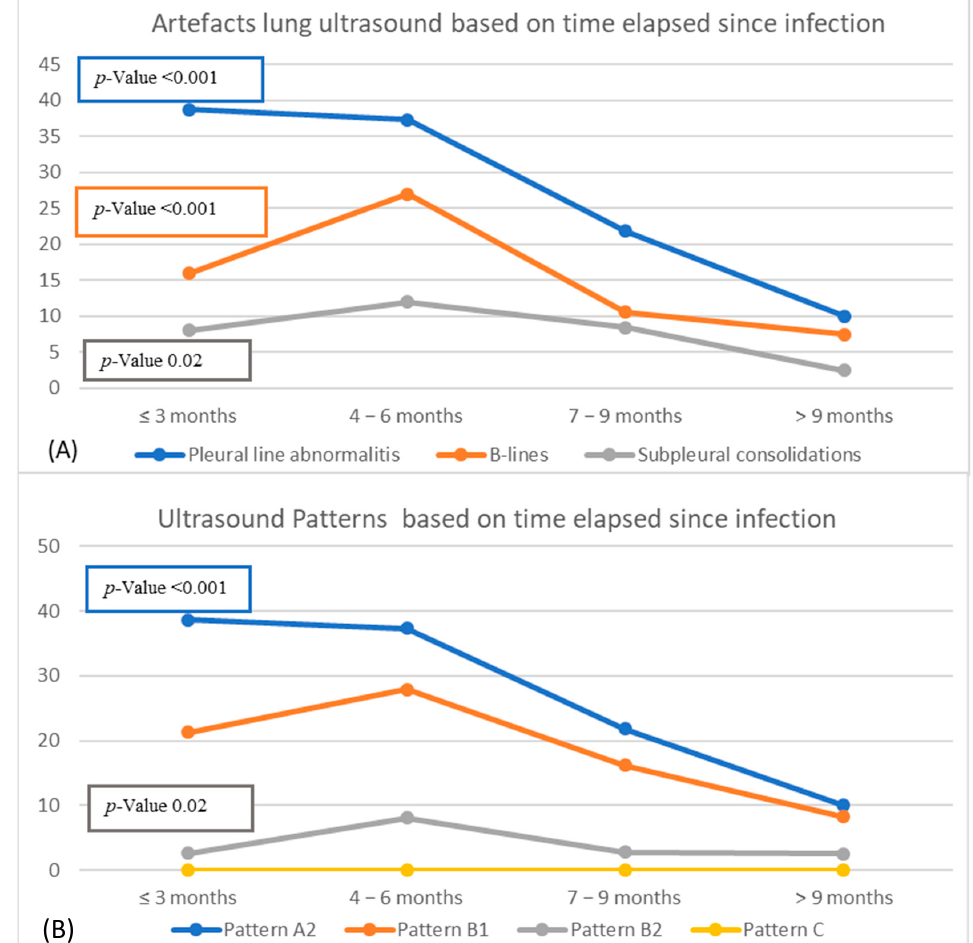
Figure 3. Association between artefacts ( A ) ─ patterns ( B ) lung ultrasound and time elapsed since infection.